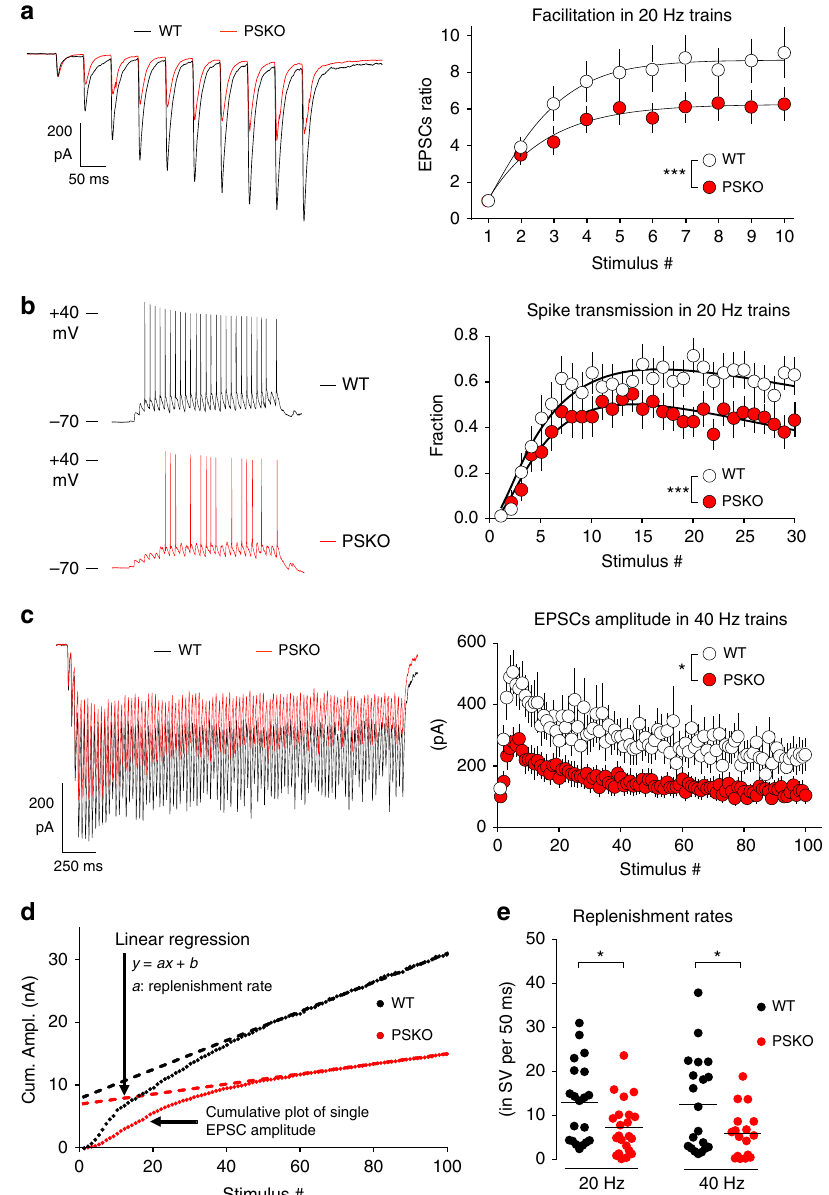
Fig. 2 PS promotes presynaptic facilitation, spike transmission, and SV replenishment. a Representative traces of EPSCs evoked by 10 repetitive light-pulses at 20 Hz, and analysis of the facilitation within the train. The facilitation is represented by the amplitude of EPSCs normalized to the amplitude of the fi rst EPSC. The facilitation is strongly impaired by absence of presynaptic PS. Two-way ANOVA, n = 19 in WT, 16 in PSKO, p = 0.0004. b Representative recordings of CA3 spikes in response to 30 stimulations at 20 Hz, and plot of the fractions of spike transmission (for 16 recorded neurons per genotype; fi ve sweeps per neuron) in WT or PSKO genotype. The highest rate of transmission (over 50%) is reached around 15 stimuli and the plot in PSKO is lower than that in WT condition (two-way ANOVA, n = 16 in WT, 18 in PSKO p < 0.0001). c Representative EPSCs evoked by 100 stimuli at 40 Hz, and the analysis of their amplitude. After the initial rising phase (facilitation), the amplitude drops and reaches a steady state that is reduced by absence of PS (two-way ANOVA, n = 20 in WT, 17 in PSKO, p = 0.03). d Graph of the cumulative amplitude of Mf-EPSCs in WT or PSKO condition from trains of stimulation plotted against the stimulus number. A linear regression fi ts the second part of the cumulative plot where a steady state is reached. The slope is proportional of the replenishment rate. e Scatter plots with means of replenishment rates calculated neuron per neuron are represented by genotype and frequency. Absence of PS decreases the rates of replenishment (unpaired t -test p < 0.05; n = 20 in WT, 22 in PSKO). Errors bars represent